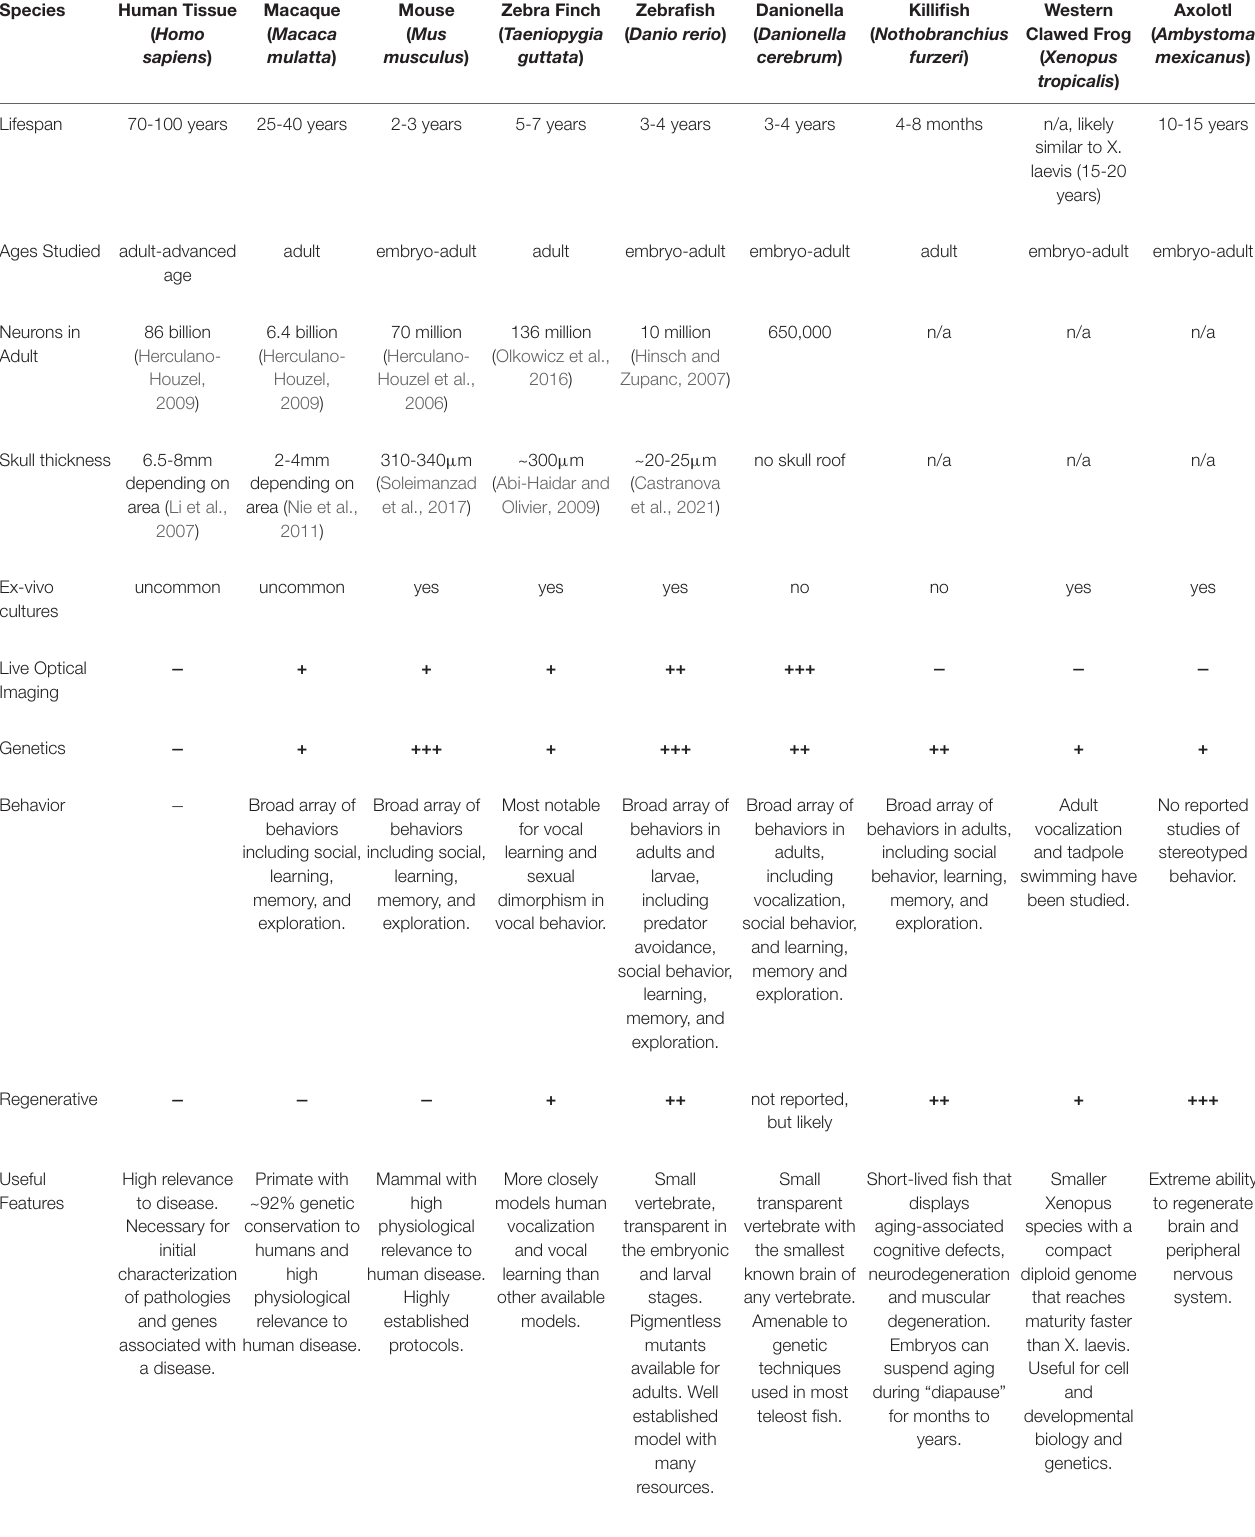
TABLE 1 | Comparative summary of a selection of common and emerging vertebrate models. Species Human Tissue (